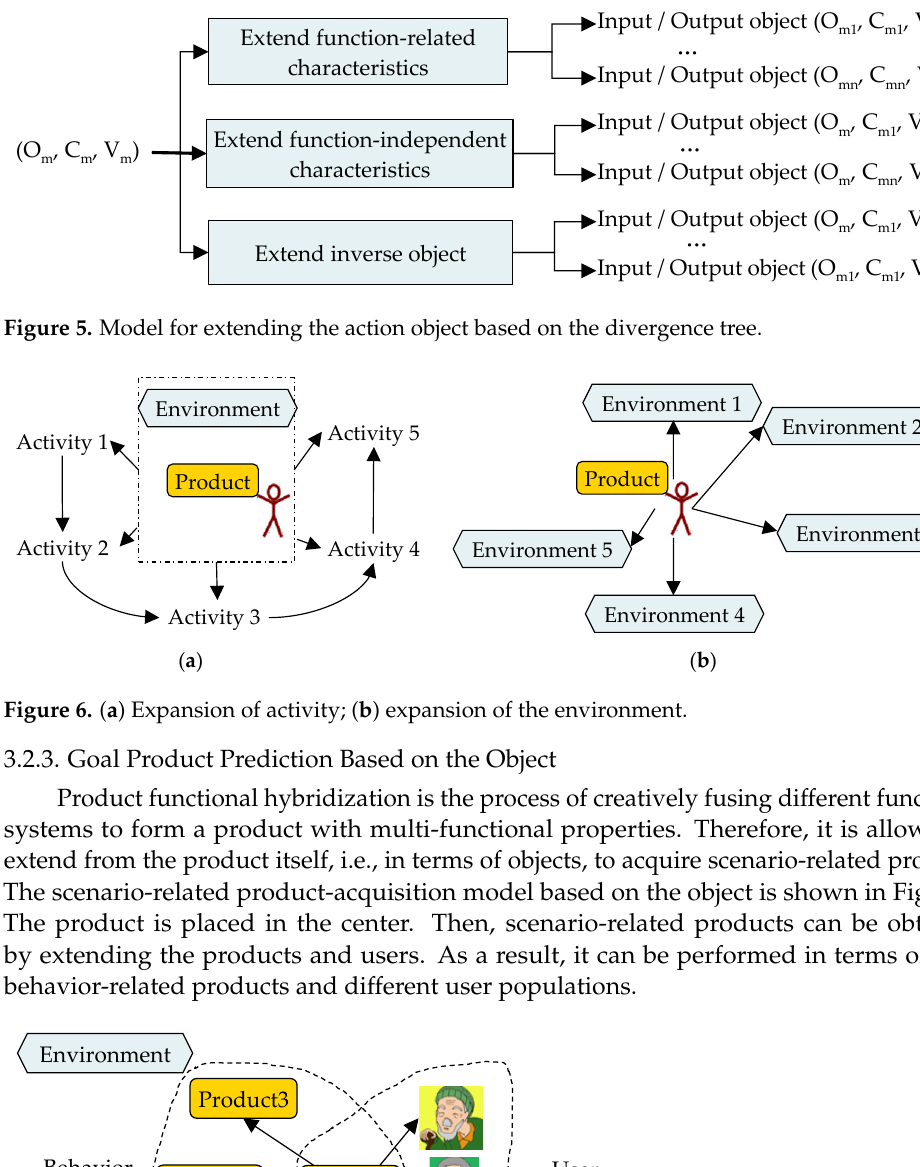
Figure 6. ( a ) The expansion of activity; ( b ) The expansion of environment.